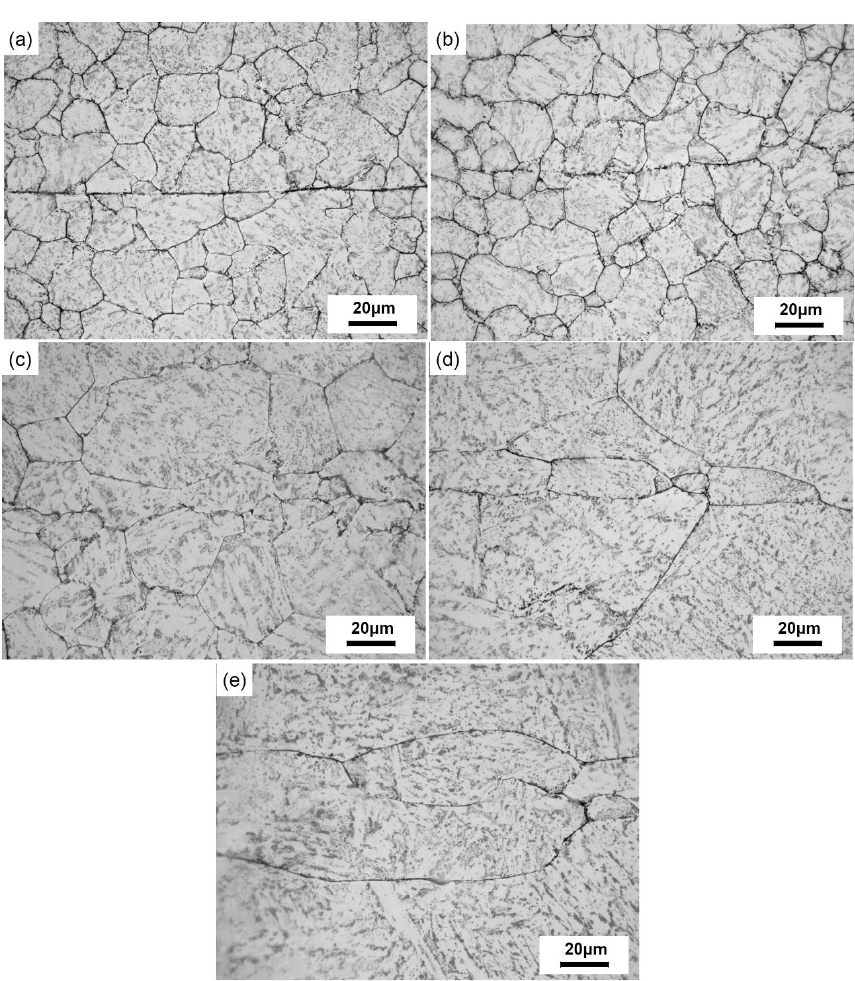
Figure 4. The microstructures on the longitudinal section of the crack healing zones in SA 508–3 steel samples with the reduction ratio of 20% under different healing temperatures for 10 h: ( a ) 850 °C, ( b )